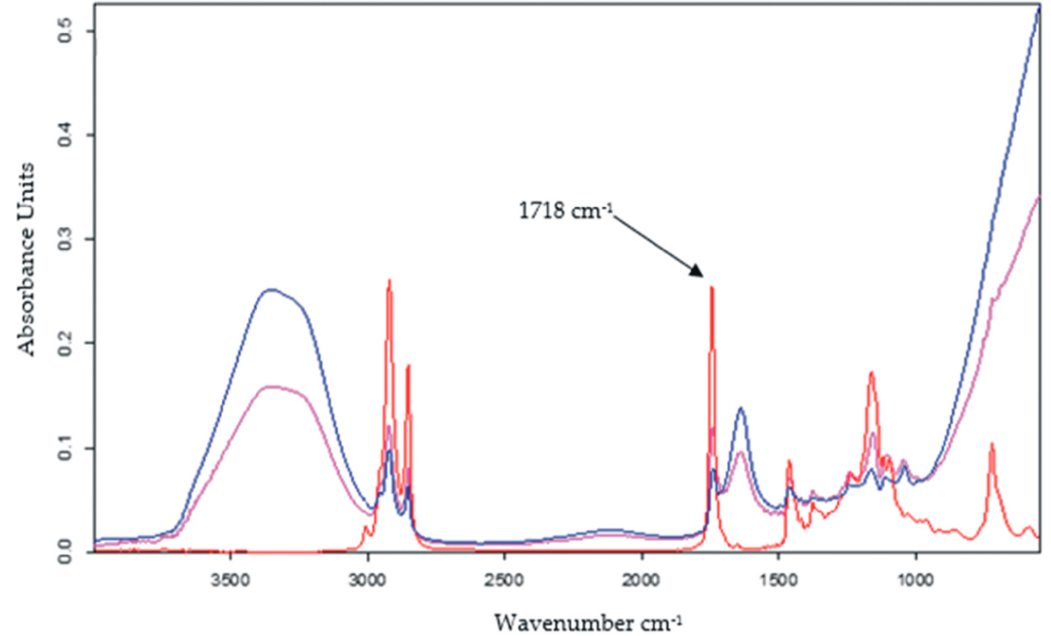
Figure 15. FTIR Spectra for: Apiterra anti-aging cream (blue line), Sabio soothing and repairing balm (red line), and Vivanatura moisturizing mattifying cream (pink line).